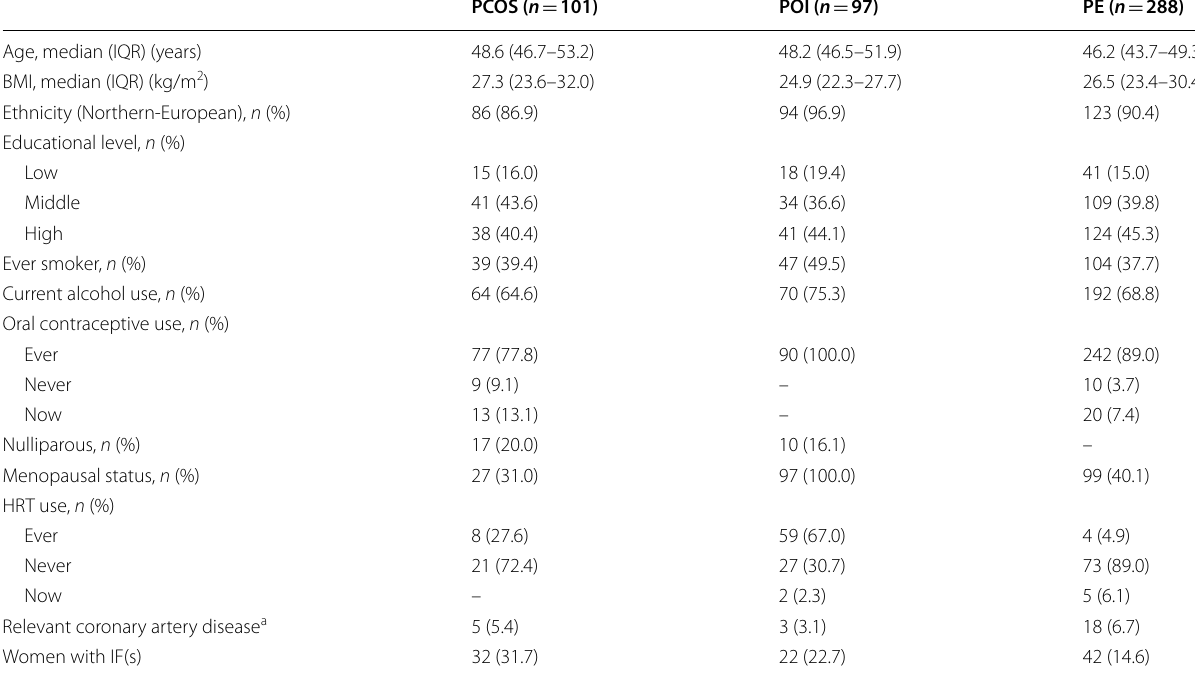
Table 1 Baseline